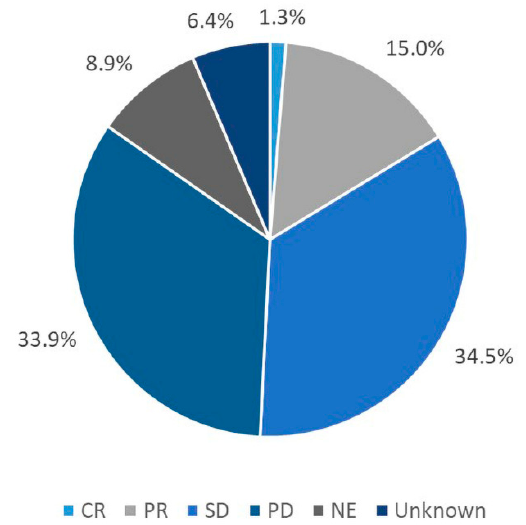
Figure 2. OZONE summary of overall response rate.CR, complete response; NE, not evaluable; PD, progressive disease; PR, partial response; SD, stable disease.